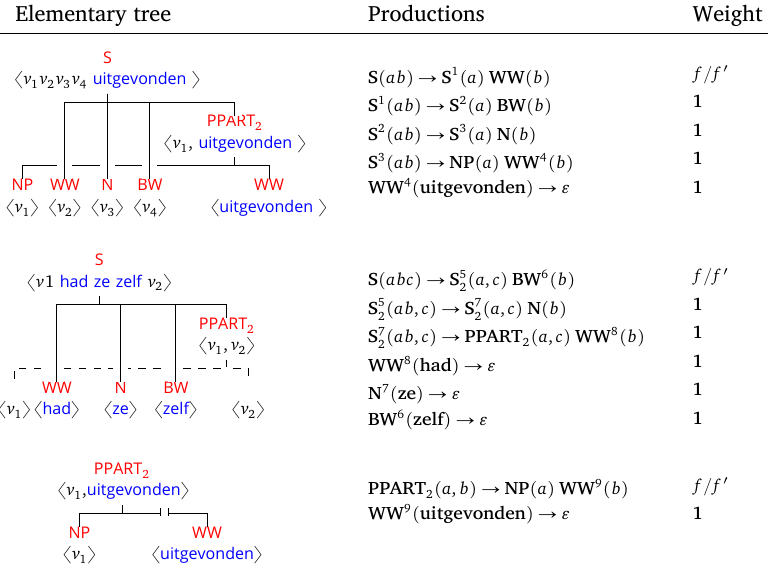
Figure 11: Transforming a discontinuous tree-substitution grammar into an lcfrs and backtransform table. The elementary trees are extracted from the tree in Figure 1 with labels abbreviated. The first production of each fragment is used as an index to the backtransform table so that the original fragments in derivations can be reconstructed.